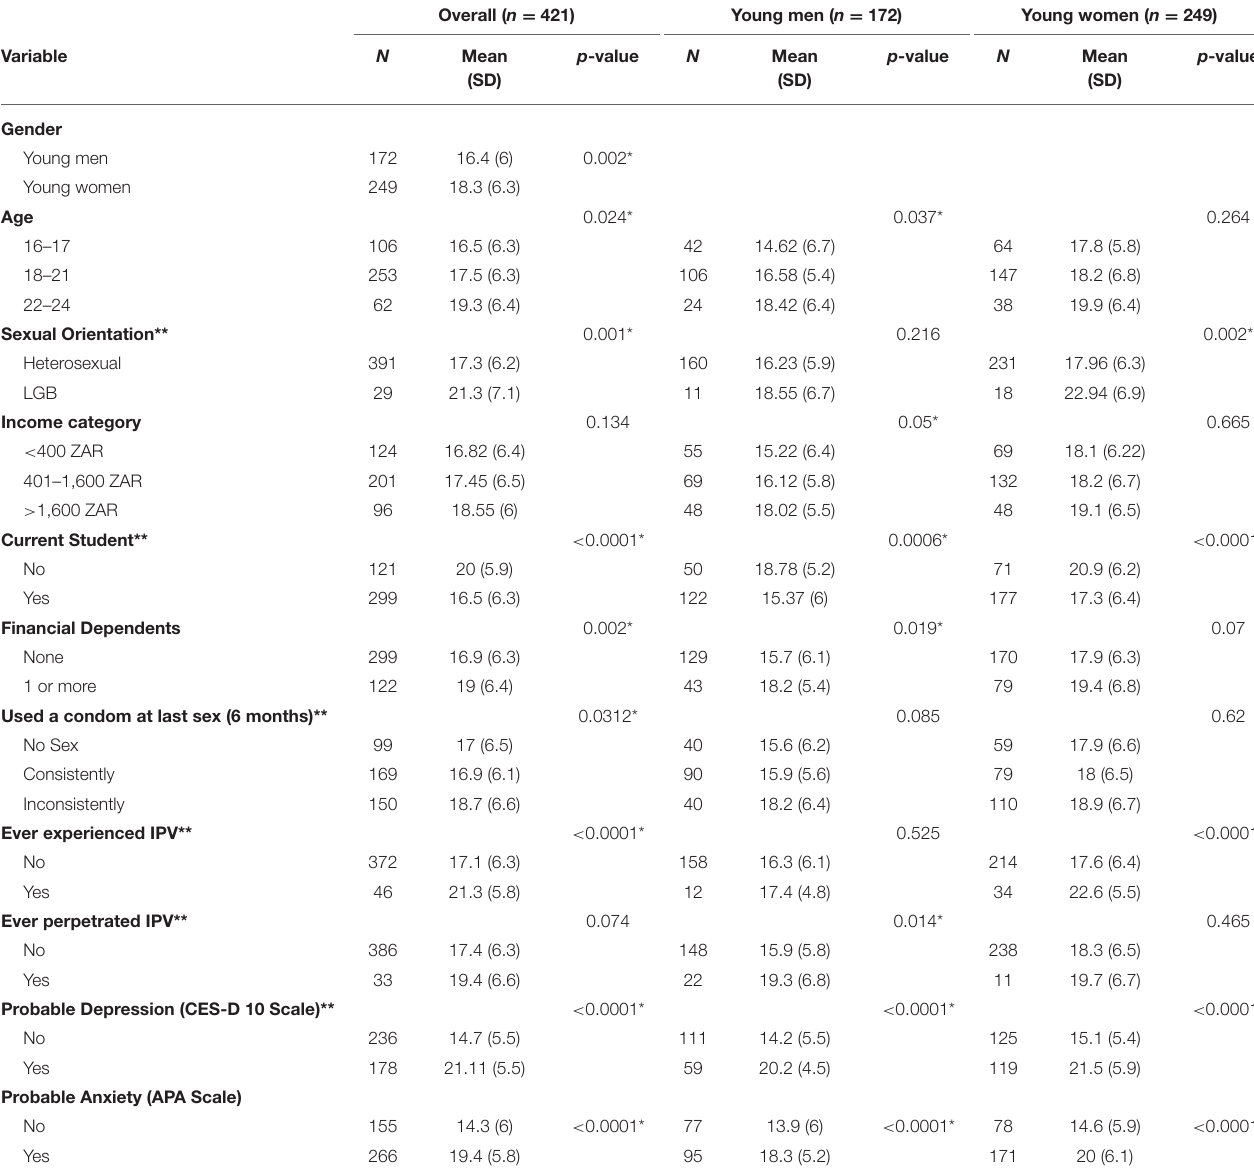
TABLE 2 | Mean (standard deviation) differences in PSS Scores by socio-demographic, sexual behavior, and mental health factors overall and stratified by gender ( n = 421). Overall ( n = 421) Young men ( n = 172) Young women ( n =